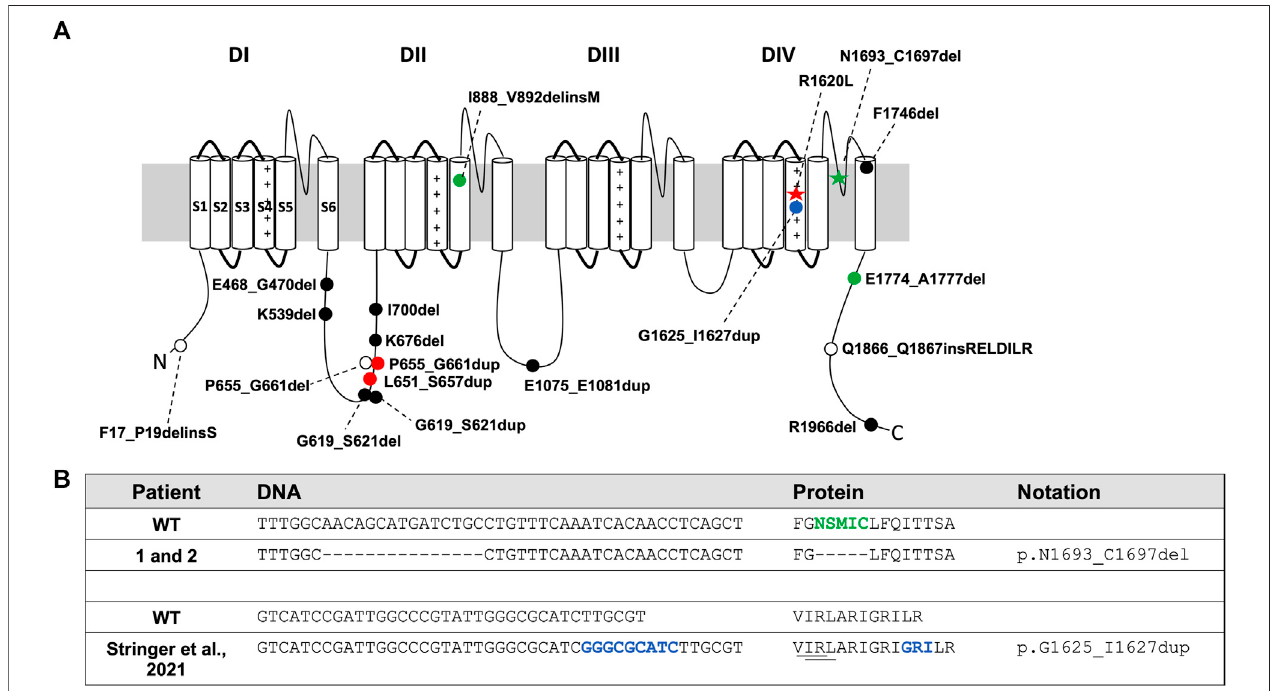
FIGURE 1 | Patient SCN8A variants and in-frame variants from gnomAD and ClinVar. (A) SCN8A channel with variants denoted by: red star, R1620L mutation; green star, in-frame deletion in Patients 1 and 2; fi lled blue circle, in-frame duplication in proband from Stringer et al., 2021; fi lled green circle, in-frame variants from Johannesen et al., 2021; open circles, in-frame deletions from ClinVar (July 2021); fi lled black circle, in-frame deletions and duplications from the gnomAD database (v2.1.1and v3.1.1; July2021); fi lledred circle, in-frame duplication inboth gnomAD and ClinVar. (B) DNAand protein sequencealignmentforPatients 1and 2and theprobandidenti fi edinStringeretal.,2021.GreenindicatesaminoacidsdeletedinPatients1and2.Dash(-)indicatesadeleted nucleotideoraminoacidcomparedto WT. Blue indicates inserted DNA nucleotides or amino acids. Underline shows close proximity of amino acids deleted in Δ VIR and Δ IRL mouse lines to the variant identi fi ed in Stringer et al.,